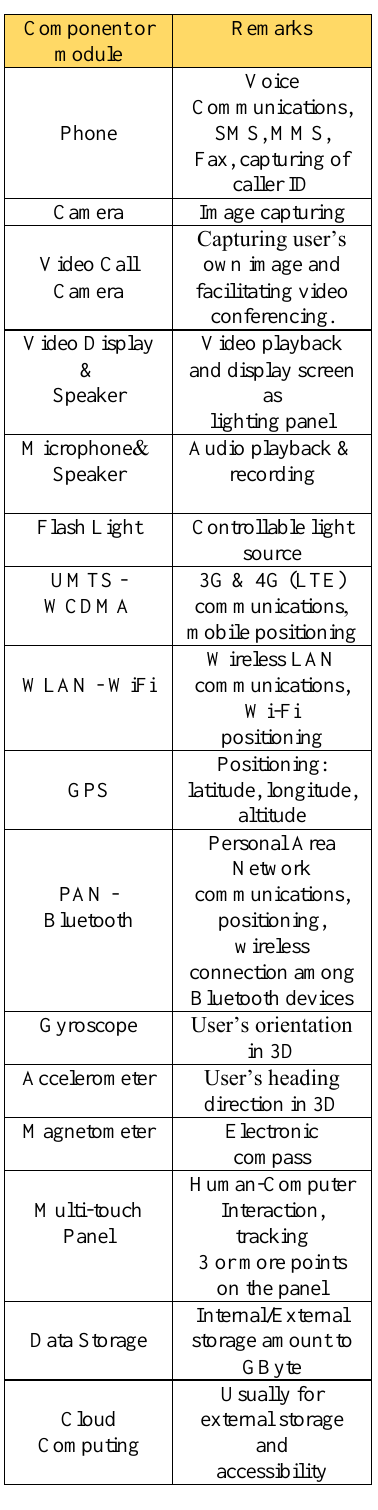
Table 1. Features and capabilities of